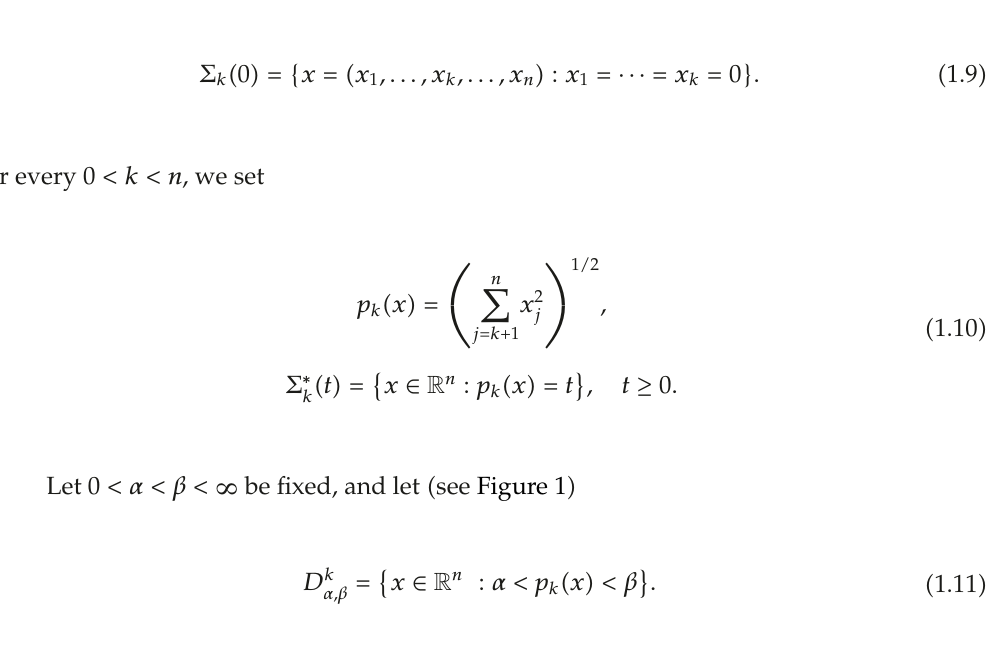
(cid:3) a (cid:4) and D 2 1 , 2